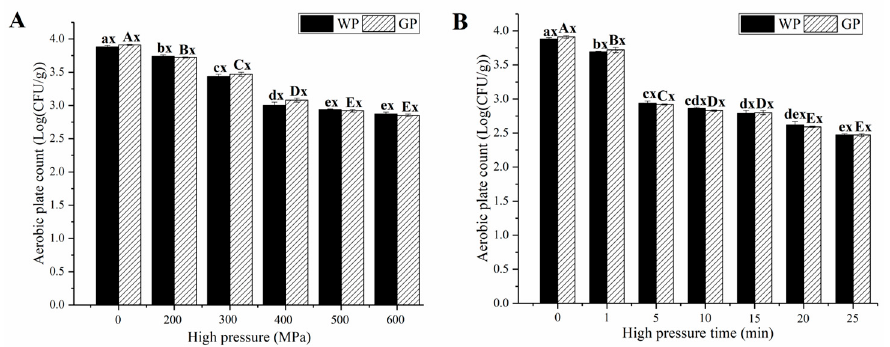
Figure 1. Effect of ( A ) HHP treatment and ( B ) pressure holding time at 500 MPa on microbial inactivation. “a–e” and “A–E” mean within WP and GP group, respectively, while different letters indicate a significant difference ( p < 0.05). “x” means there was no significant difference ( p ≥ 0.05) between WP and GP under the same HHP condition.